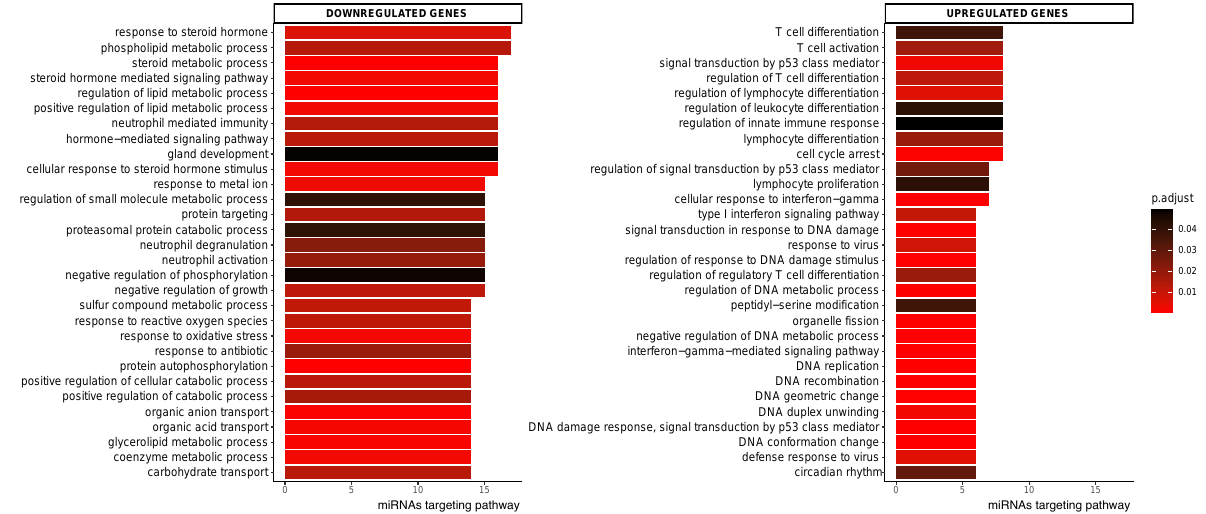
Figure 3. Top 30 enriched GO pathways associated with the down- or upregulated genes in CeD that are targeted by at least one miRNA. Sorted by how many miRNAs targeted the transcripts in the pathway. The colorscale indicates significance of pathway enrichment as indicated with